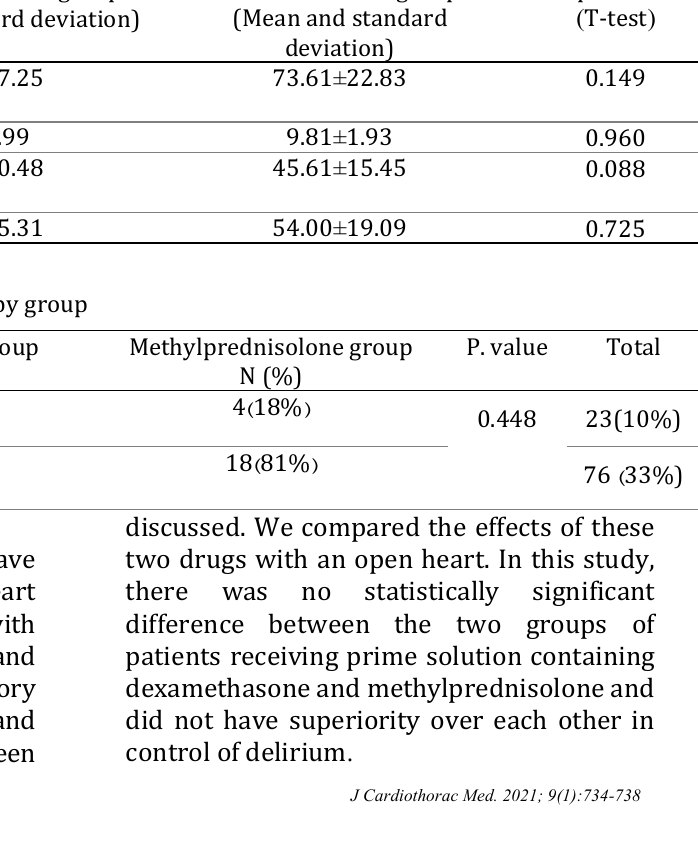
Table 1: Quantitative underlying variables specific to heart surgery